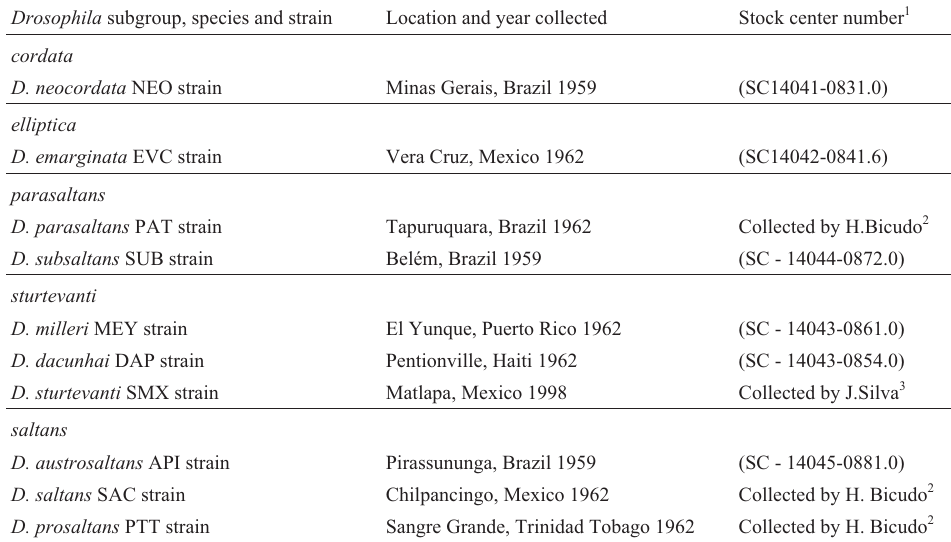
Table 1 - Details of the Drosophila saltans species and strains used in this study. Drosophila subgroup, species and